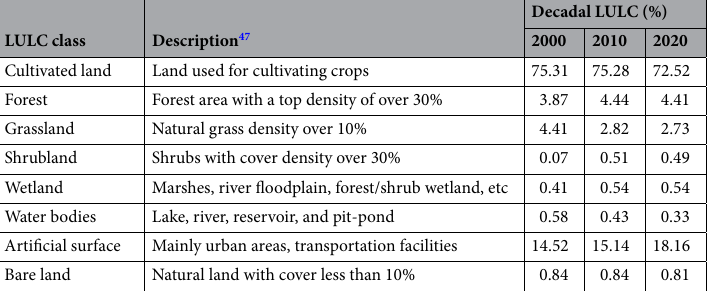
Table 1. Land use/Land cover classification and the percentage coverage from the total area for 2000, 2010, and 2020 in the study